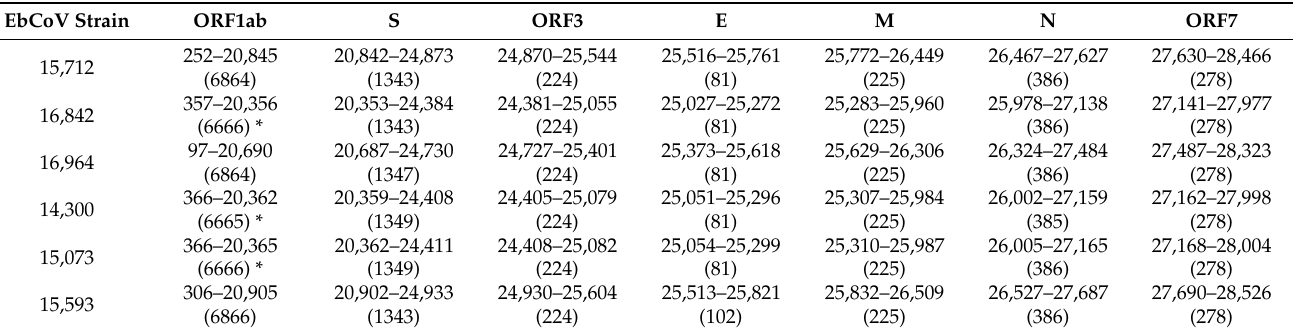
Figure 2. Genome organization of Eptesicus bat coronavirus. Genes for ORF1ab, Spike (S), ORF3 (3), Envelope (E), Membrane (M), Nucleocapsid (N), and ORF7 (7) are denoted. Table 2. Genome organization of Eptesicus bat CoV strains determined from E. fuscus . Nucleotides for genes are shown. Predicted protein lengths are shown in parentheses. Incomplete sequences are indicated by *.